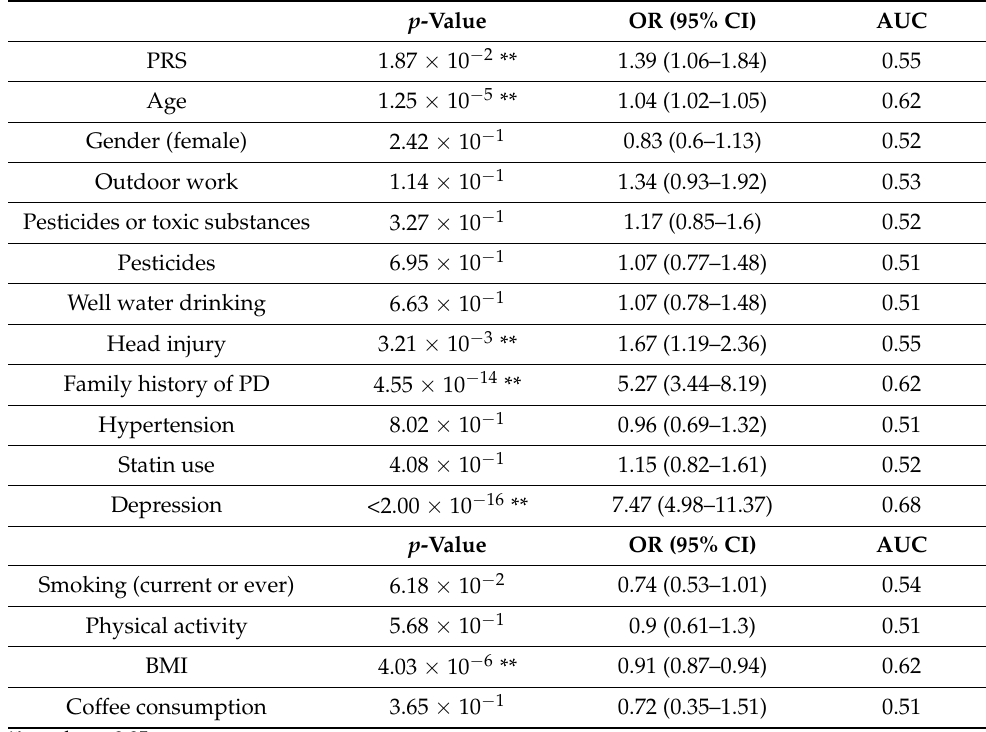
Table 3. Univariate-logistic regression analysis of lifestyle/environmental exposure risk factors before